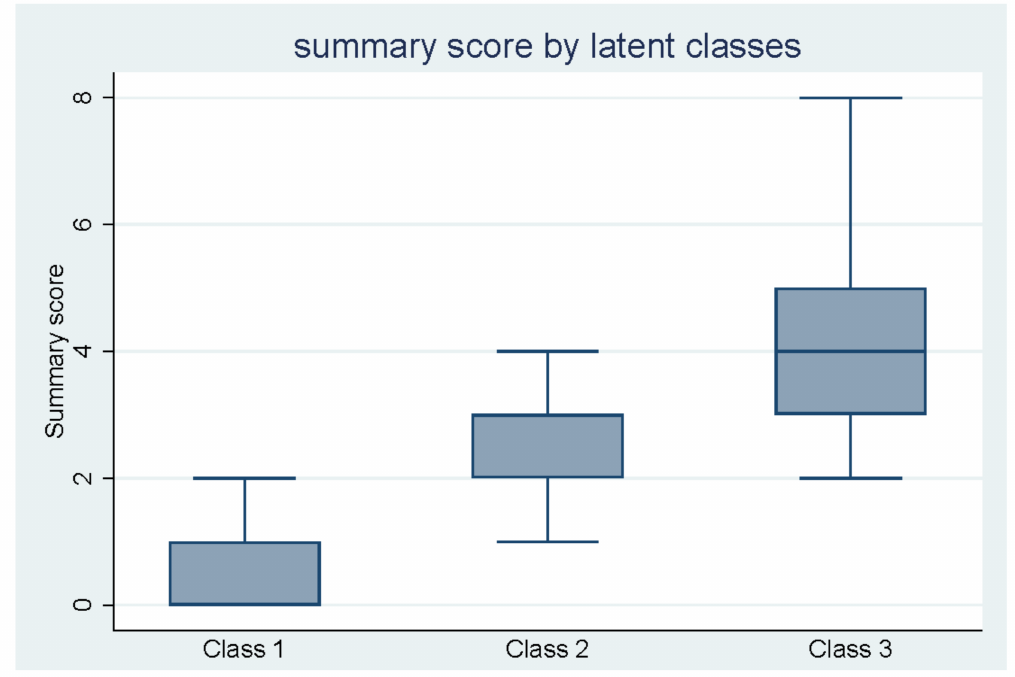
Figure 5. Boxplot comparing the summary score by the three classes identified in the latent class analysis. The blue center line denotes the median value (50th percentile), while the blue box contains the first (25th percentile) to third quartile (75th percentiles) of the dataset. The blue whiskers mark the first and third quartile minus/plus 1.5 times the interquartile range. Values beyond these upper and lower bounds are considered outliers and excluded in the